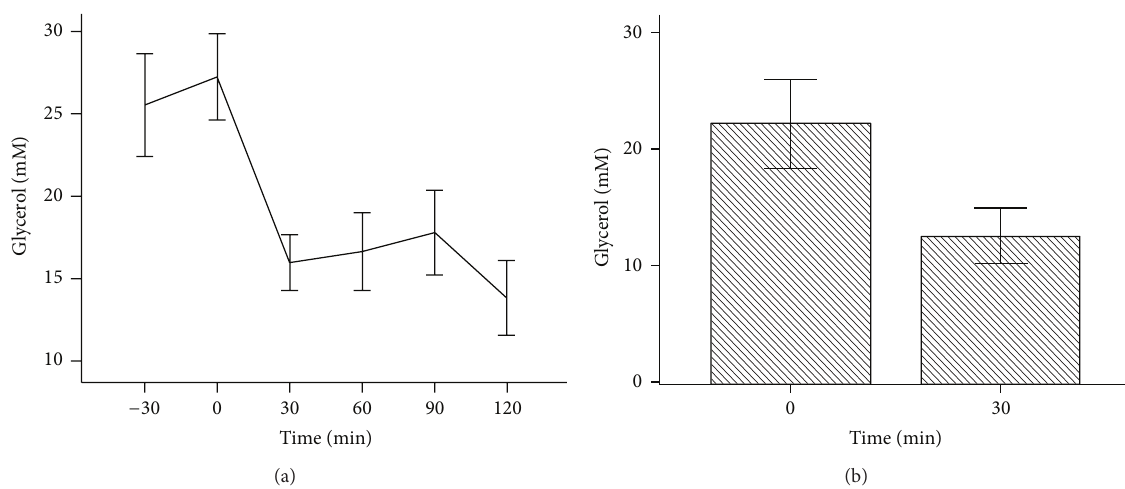
Figure 3: Glycerol levels during HIEC. Plasma glycerol was measured as shown in Study Subjects. (a) showed glycerol levels drop between time 0 min and 30 min and then stayed steady. (b) showed glycerol at time 30min is significantly lower than glycerol levels at time 0min ( 𝑃 < 0.001 ).